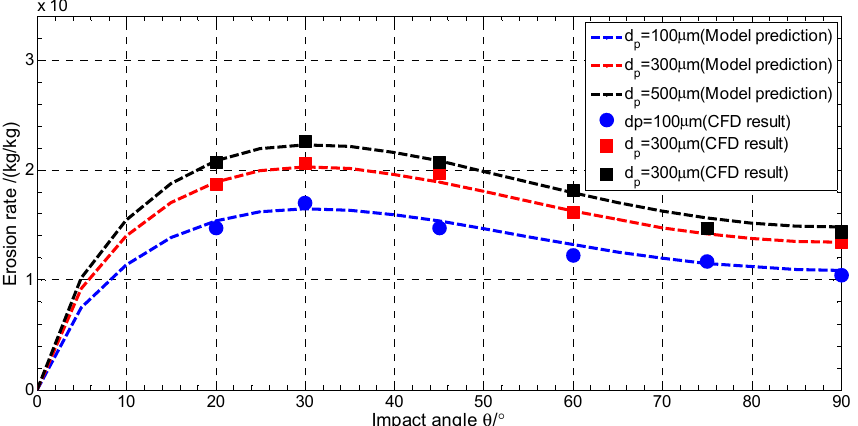
Figure 17. A comparison diagram of the erosion rate at different impact angles and particle sizes (using Q235 carbon steel and a gas velocity of v g = 60 m/s).